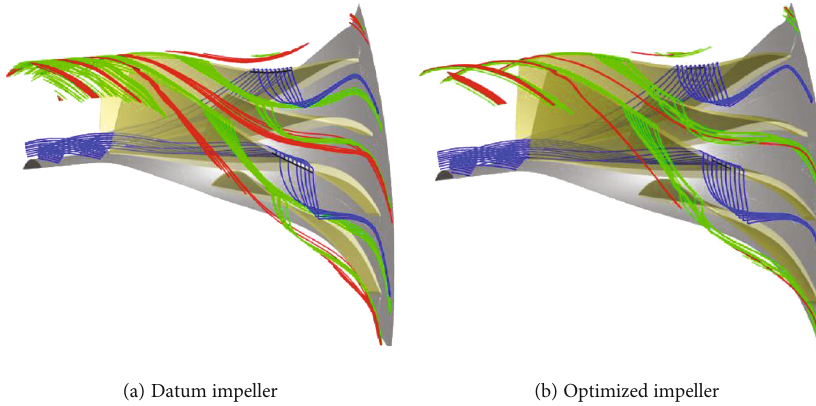
Figure 14: Tip clearance fl ow